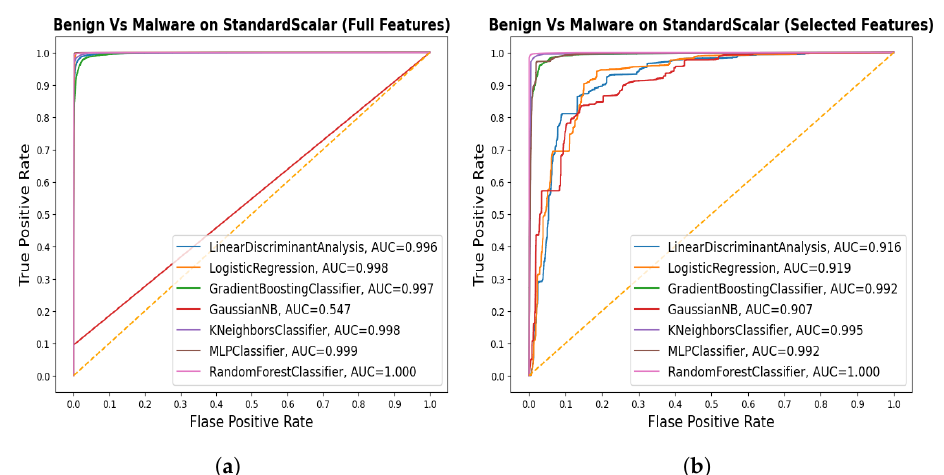
Figure 8. ROC curves for difference classifiers for malware detection problem. ( a ) Full Features; ( b ) Selected